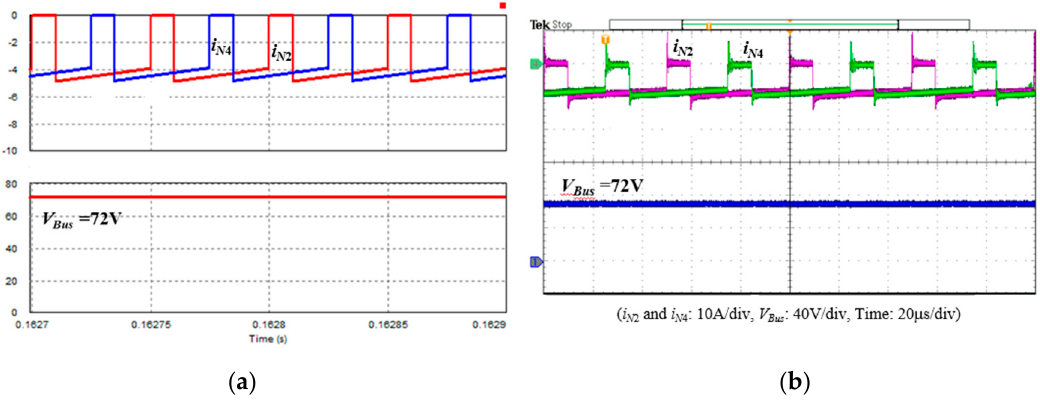
Figure 22. The waveform of the secondary-side currents of the coupled inductor and DC-bus voltage in the dual-energy in series discharge mode with D d = 0.25: ( a ) simulated and ( b ) experimental.